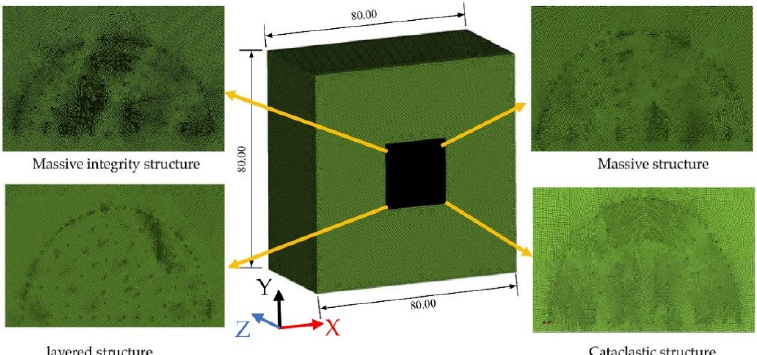
Figure 8. Finite element model (unit: m).